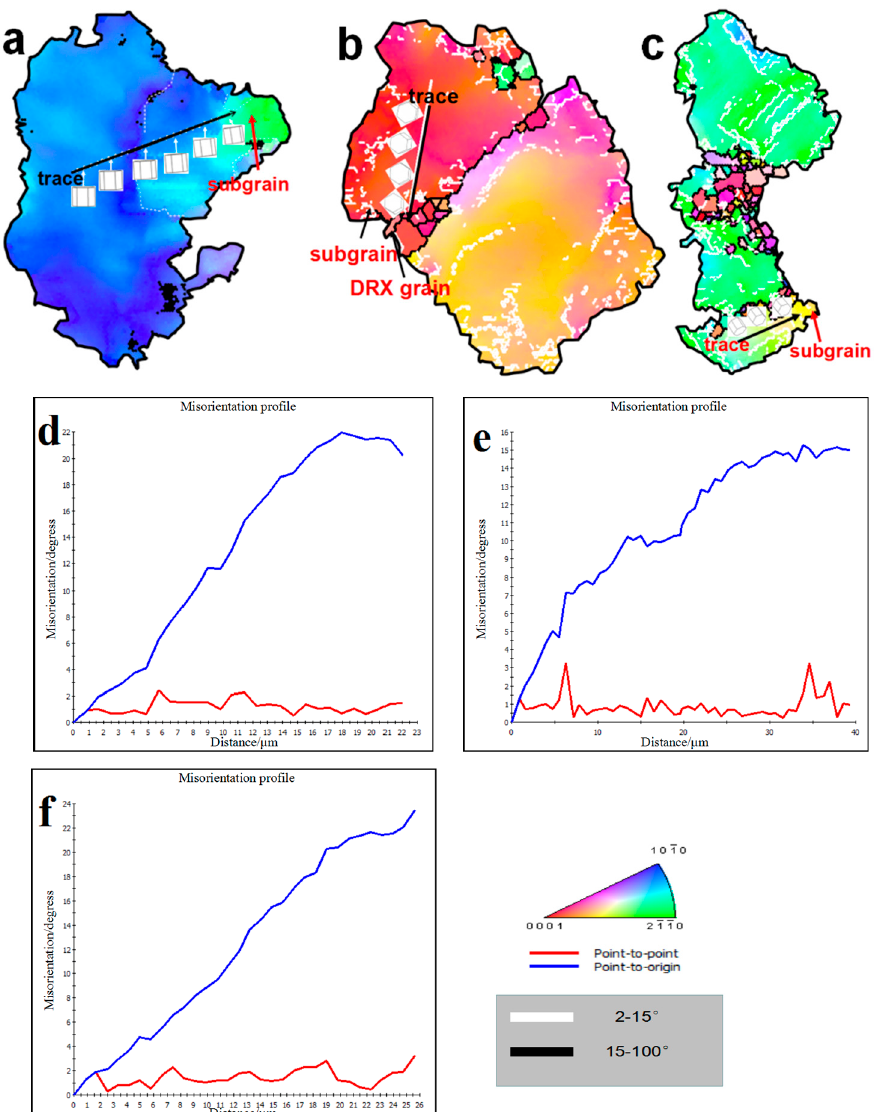
Figure 14. ( a – c ) An enlarged map of the selected area from Figure 13a–c; ( d – f ) The misorientation profiles measured along the trace in Figure 14a–c, respectively.